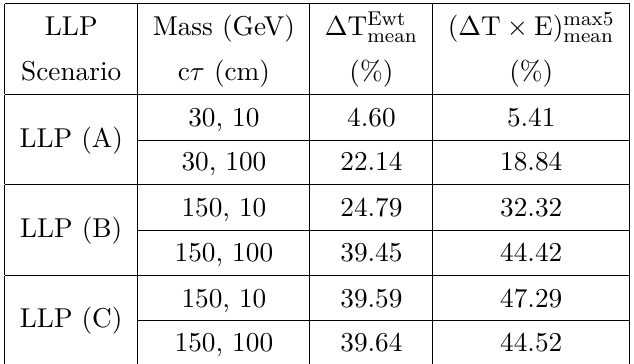
Table 4 . Trigger efficiency for three benchmark masses from the three LLP scenarios with cτ = 10 cm and 100 cm calculated by putting suitable thresholds on the two timing variables as well as the number of displaced L1 tracks associated with the jet to keep the background rate restricted at ≈ 30 kHz when the ECAL timing resolution corresponding to 300 fb − 1 luminosity is